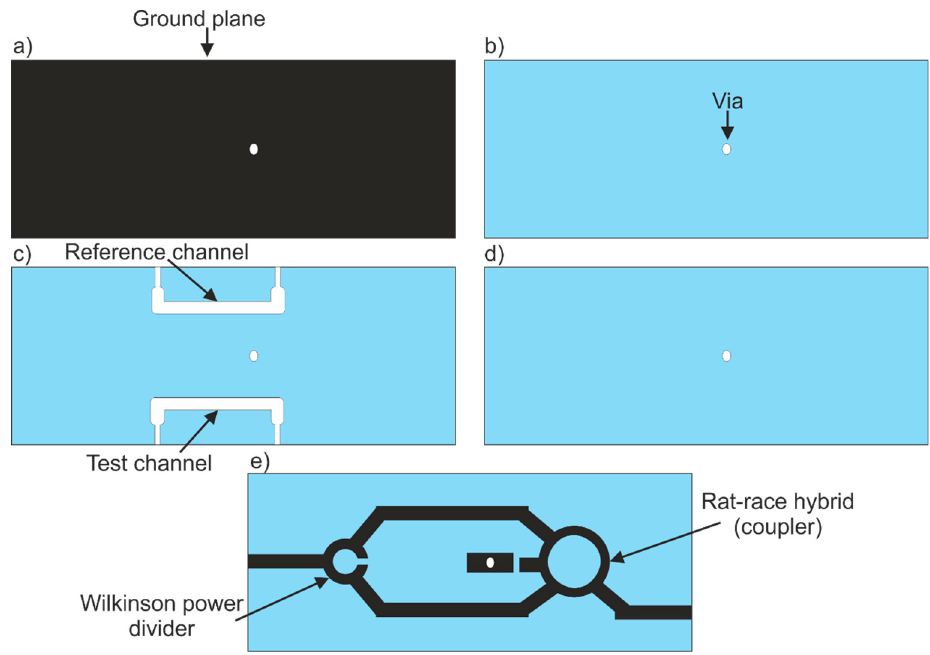
Figure 7. The LTCC layers for the coupler-based sensor: ( a ) bottom layer with deposited ground plane and via hole, ( b ) bottom layer with via hole, ( c ) middle layer with reference and test channels, ( d ) cover layer with via hole, ( e ) top layer with deposited microwave circuits.